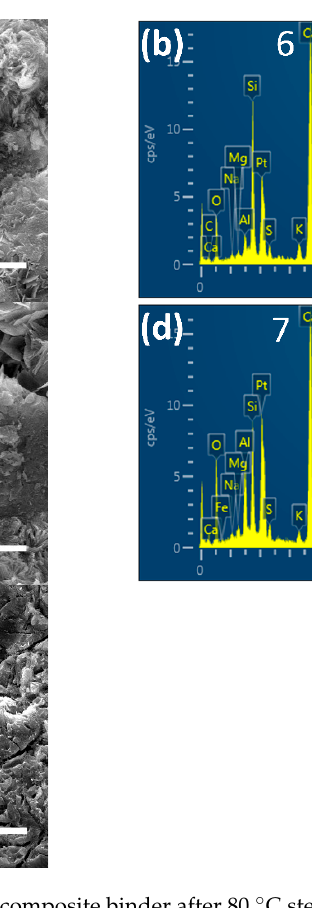
Figure 7. SEM images of pure cement paste after 80 °C steam curing for 7 d, ( a ) fibrous C-S-H gels; ( b ) EDS result of area 5; ( c ) spherical hydrogarnet and crack.